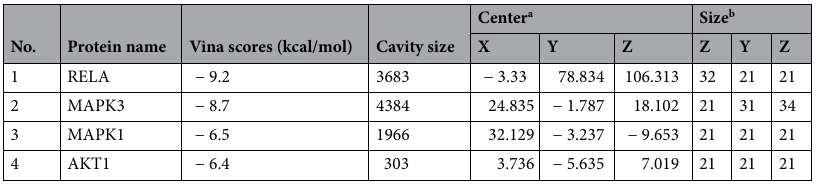
Table 3. Molecular docking parameters and results for the 4 targets that bind to naringenin. a Docking pocket center coordinates. Unit: angstroms. b Size of the docking pocket in the X, Y, and Z directions. Unit: angstroms.